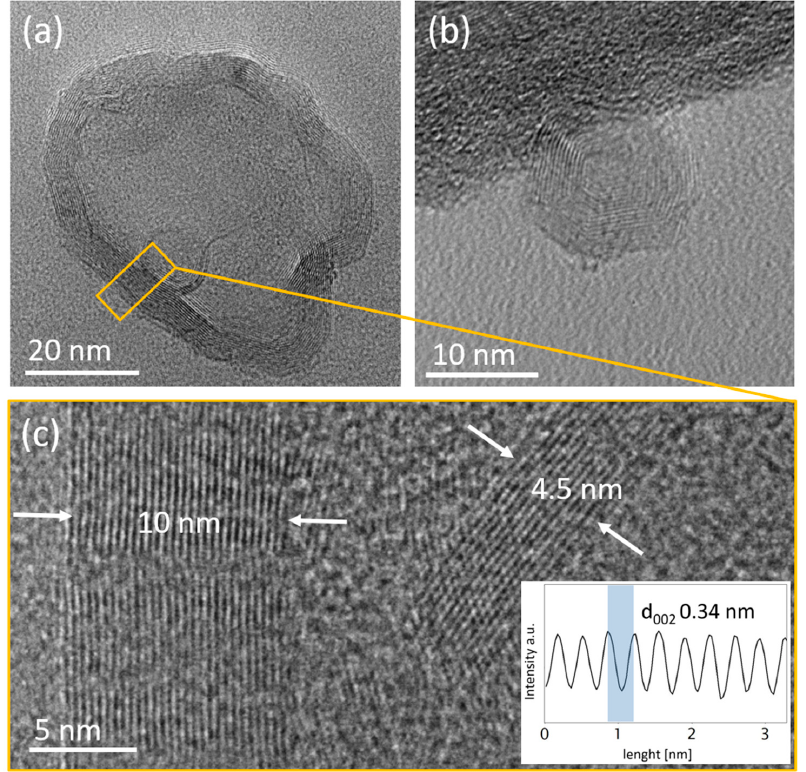
Figure 3. Representative TEM bright-field micrographs of NBC. ( a ) two NBC particles of different sizes; ( b ) NBC with small hollow core ( c ) enlarged view of ( a ) at high magnification; the inset shows an intensity line-scan measure of the interlayer spacing d002.